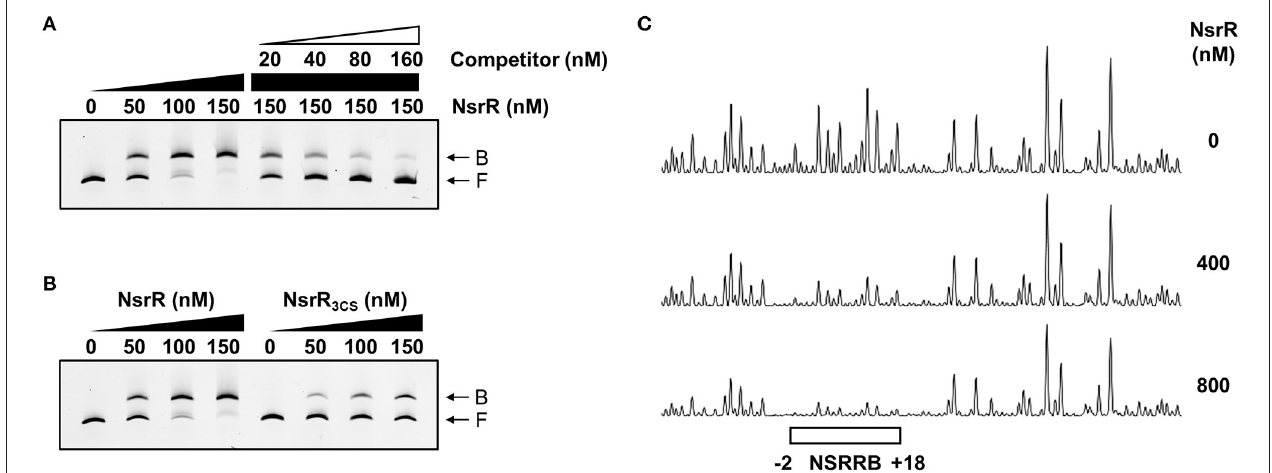
FIGURE 5 | Specific binding of NsrR to the nsrR - hmpA regulatory region. (A,B) A 393-bp DNA fragment of the nsrR - hmpA regulatory region (10nM) was labeled with 6-FAM, and then incubated with increasing amounts of NsrR (A,B) or NsrR 3CS (B) as indicated. For the competition analysis, various amounts of the unlabeled DNA fragment were added as a self-competitor. B, bound DNA; F, free DNA. (C) The same DNA probe (40nM) was incubated with increasing amounts of NsrR as indicated, and then digested with DNase I. The region protected by NsrR is indicated by a white box (NSRRB). Nucleotide numbers shown are relative to the TSS of hmpA .